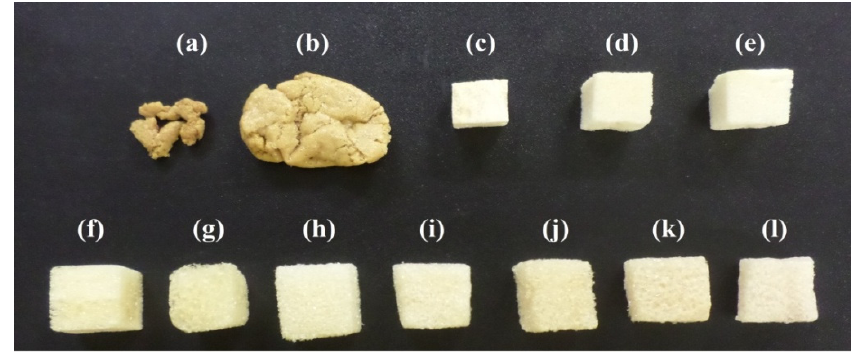
Figure 1. Foams produced varying the pure glycerol content: ( a ) 20%; ( b ) 40%; ( c ) 50%; ( d ) 60%; and ( e ) 80%,as well as varying the crude glycerol content: ( f ) 10%; ( g ) 20%; ( h ) 30%; ( i ) 40%; ( j ) 50%; ( k ) 60%; and ( l ) 70% of the polyols.